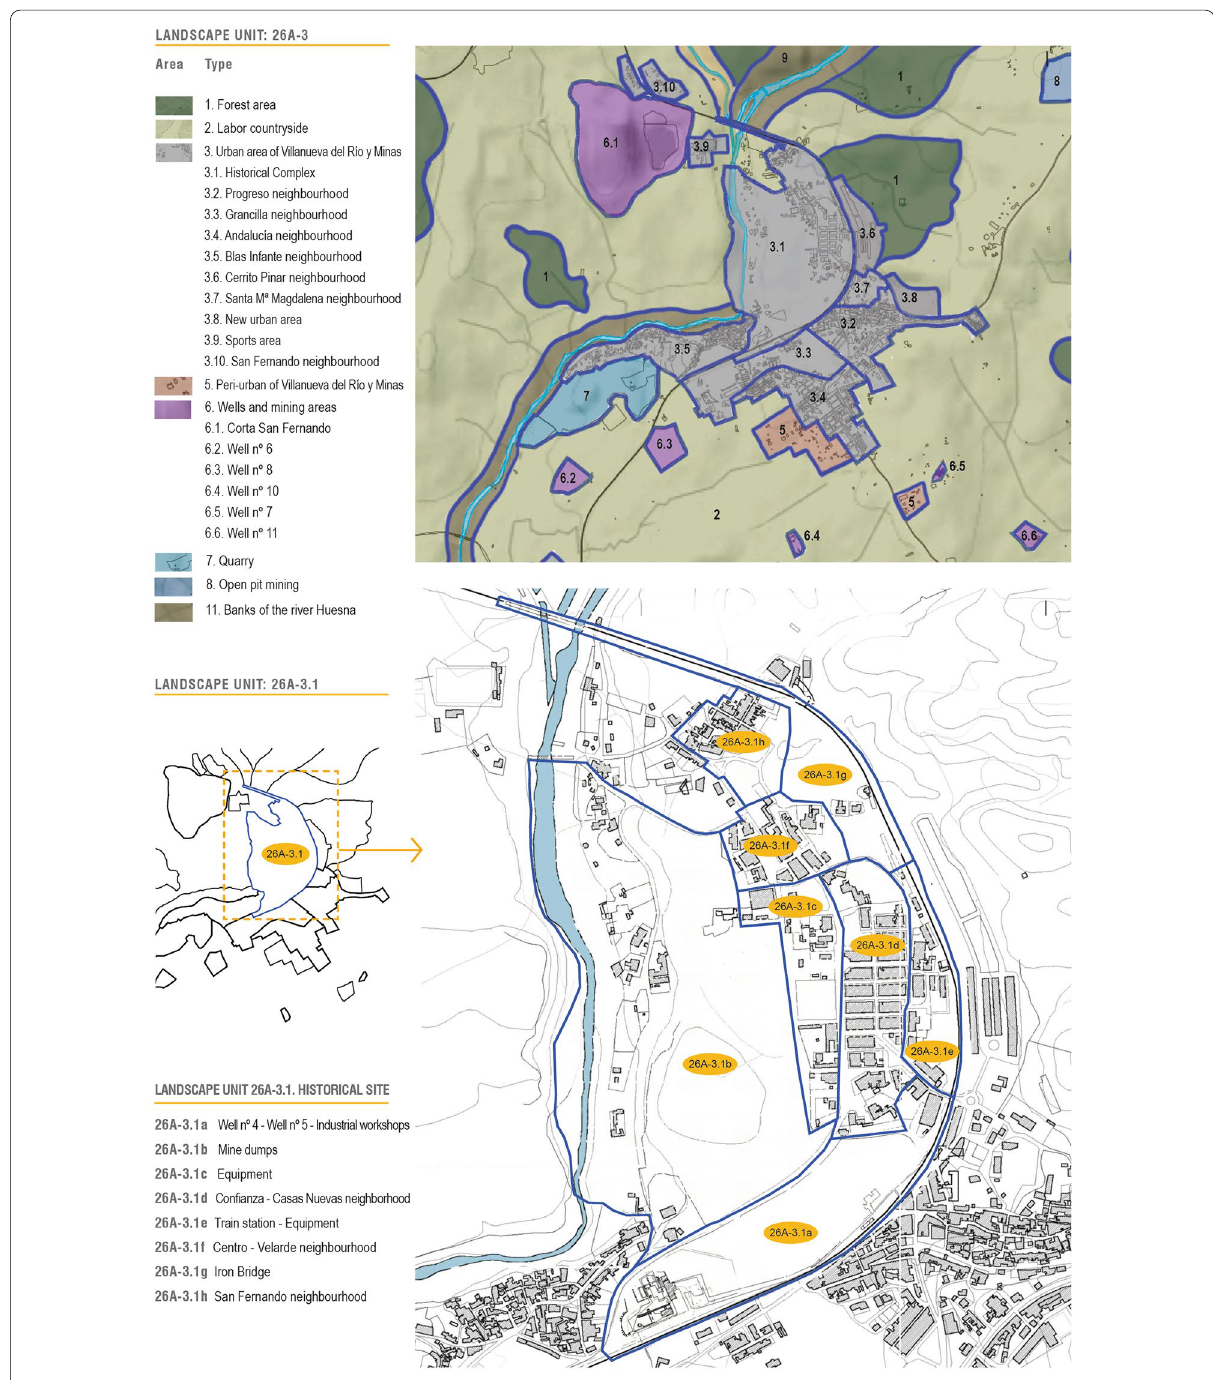
Fig. 4 Identification and delimitation of landscape units at different scales. Source: Own